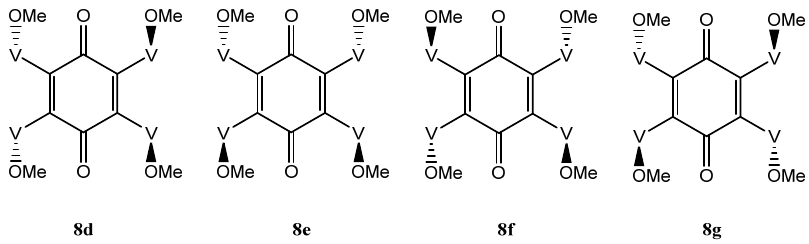
Figure 7. Tetra-adducts with two vindolines with same orientation.